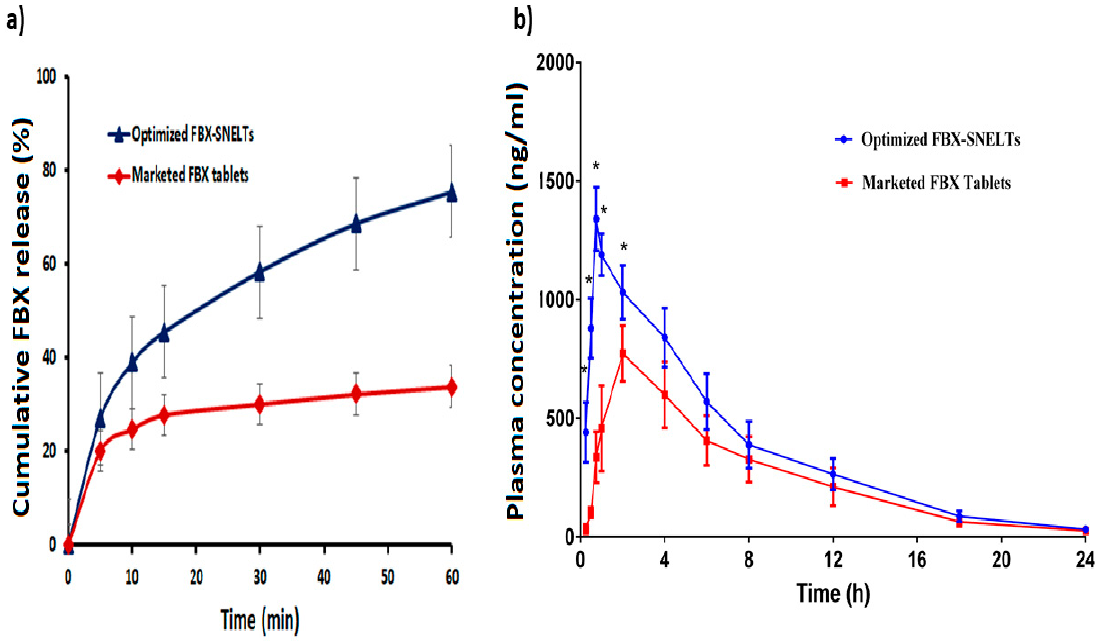
Figure 7. Comparative release profiles ( a ) and plasma concentration–time curves ( b ) between the optimized FBX-SNELTs and marketed tablets.